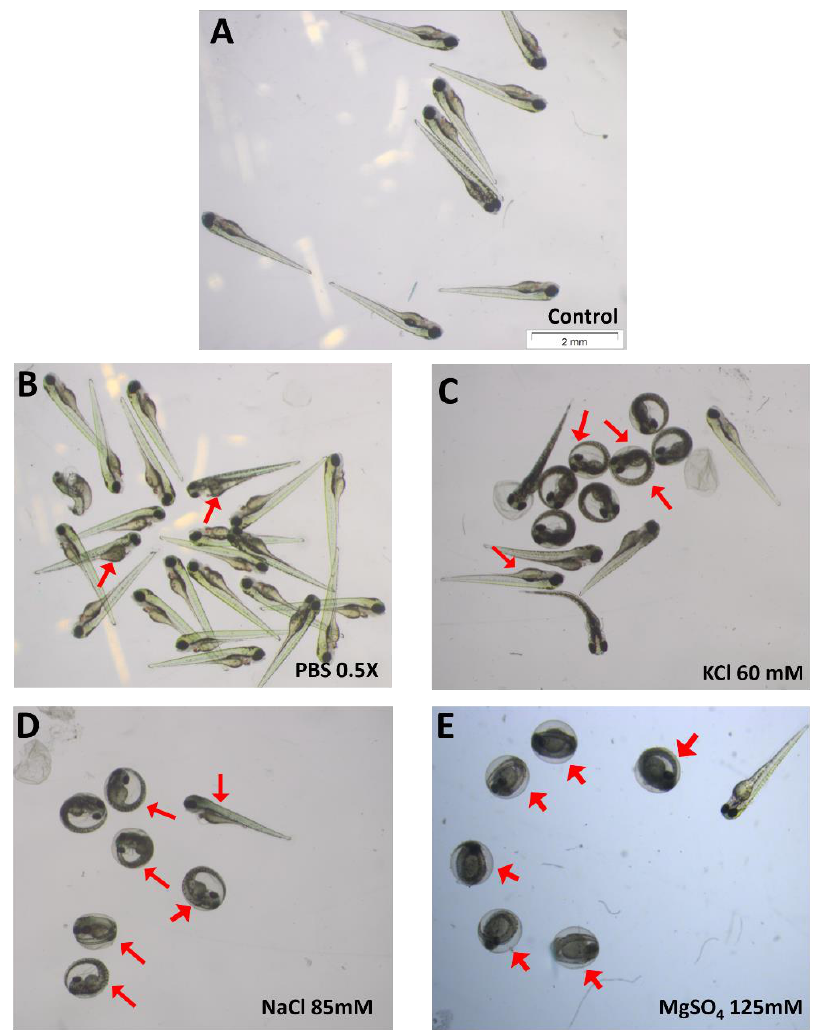
Figure 4. The 4 dpf embryos exposed showing different levels of darkened yolk (red arrow) in high salt solutions. ( A ) Control; ( B ) PBS 0.5X; ( C ) KCl 60 mM; ( D ) NaCl 85 mM; ( E ) MgSO 4 125 mM.